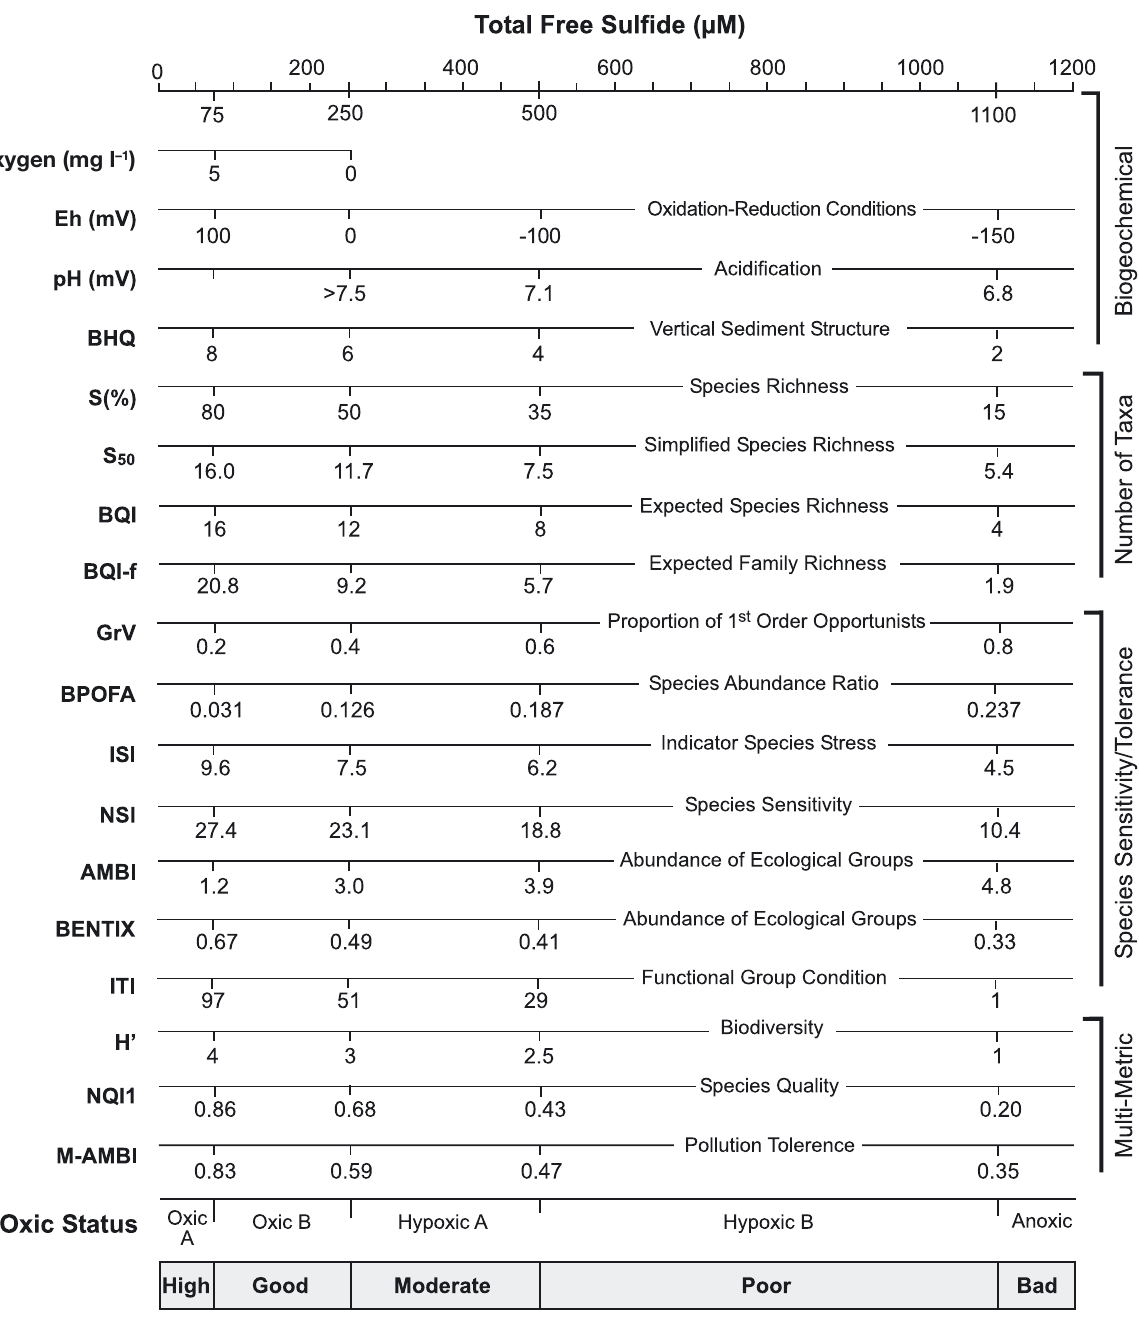
Fig. 10. Numerical ecological quality status (EQS) classes for benthic organic enrichment based on abiotic and biotic indicators. Equivalent EQS boundaries for total free sulfides, redox potential (Eh), Shannon-Wiener diversity (H’) , species richness (S %), group V opportunistic species (GrV), and AZTI’s Marine Biotic Indices (AMBI and M-AMBI) are from Cranford et al. (2020). Sediment oxygen EQS zones are from the present study. pH and benthic polychaete opportunistic families amphipod index (BPOFA) classes are from Schaaning & Hansen (2005) and Dauvin et al. (2016), respectively. The benthic habitat quality (BHQ) and number of species among 50 individuals (S 50 ) boundaries are derived from relationships in Hargrave (2010). Benthic quality index (BQI), benthic quality families index (BQI-f), infaunal trophic index (ITI), and BENTIX boundaries are from Rosenberg et al. (2004), Dimitriou et al. (2012), Ruellet & Dauvin (2007), and Simonini et al. (2009), respectively. The Norwegian quality (NQI1), sensitivity (NSI) and indicator species (ISI) index classes are from Husa et al. (2014) and Rygg & Norling